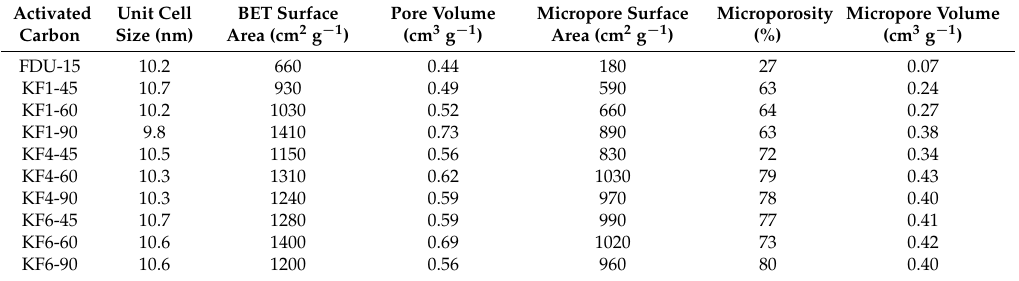
Table 7. Structural data (e.g., unit cell size, surface area and pore volume) of the activated carbon prepared from low to high KOH/C ratio. FDU-15 represents the pristine ordered mesoporous carbon, while KF x - y represents the KOH activated FDU-15, x represents the KOH/C ratio and y represents the activation time. Reproduced from [115], with permission from Royal Society of Chemistry,